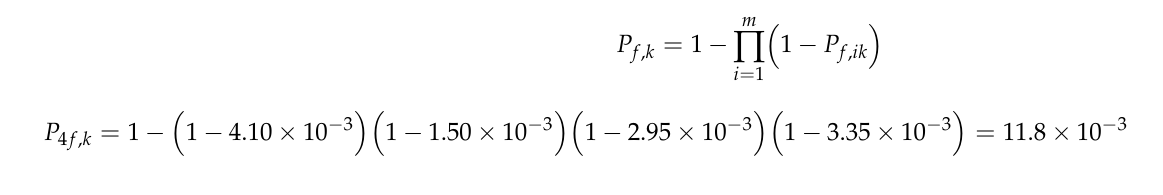
Table 9. Annual probability of exceedance limit state accounting for three failure mechanisms before and after the retrofitting